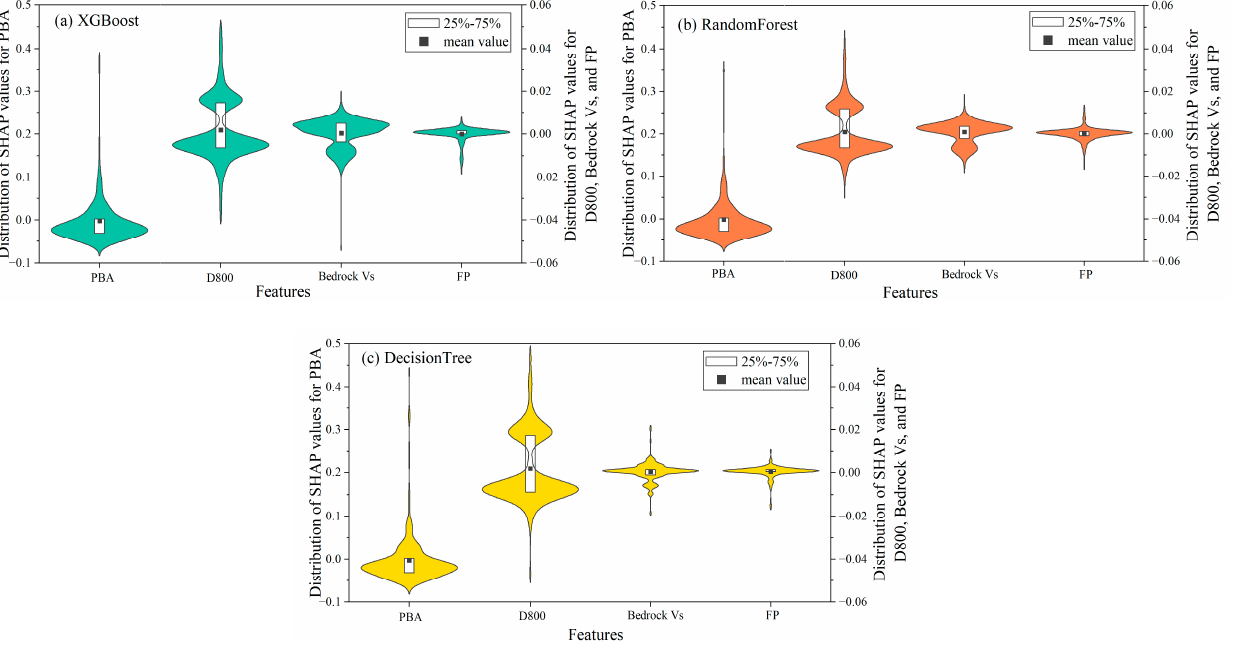
Figure 14. Distributions and densities of the SHAP values for ( a ) XGBoost, ( b ) Random Forest, ( c ) Decision Tree. ( c ) Decision